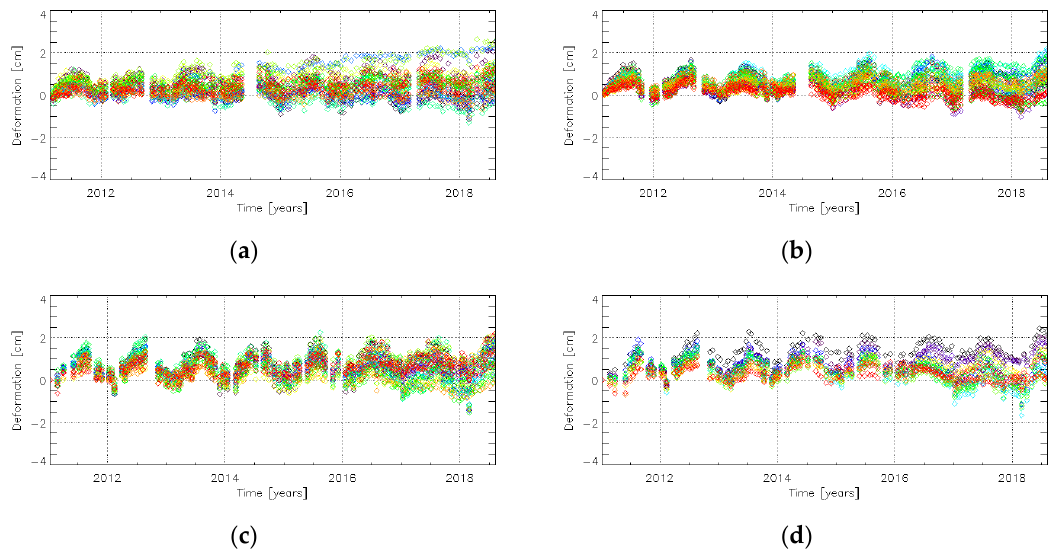
Figure 13. Plots of the estimated deformation time series for the coherent pixels in the area of interest of the collapsed pillar provided in Figure 12 for the ( a ) SBAS and ( b ) TomoSAR results achieved for the ascending dataset, and ( c ) SBAS and ( d ) TomoSAR results related to the descending dataset.